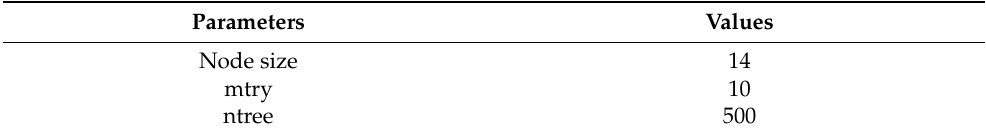
Table 2. Parameters used in RF